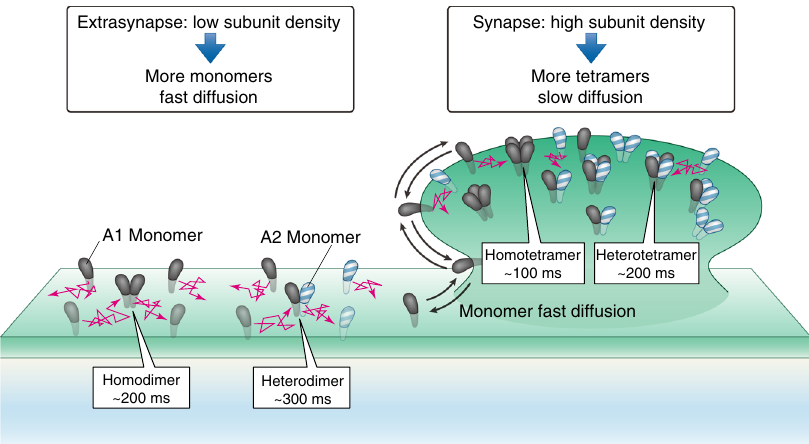
Fig. 9 AMPAR subunits diffuse as monomers and dimers between the dendritic shaft and the synaptic region. Schematic fi gure showing that the AMPAR subunits GluA1 and GluA2 predominantly exist as monomers, and occasionally form transient dimers (and less frequently transient trimers and tetramers) in their reserve pools in the dendritic-shaft PM, where the subunit concentrations are low. Monomers and dimers diffuse quite freely in the dendritic-shaft PM, and enter the spines. In the synaptic regions in the spines, where the AMPAR subunit concentrations are high due to their binding to (plus their transient associations with) scaffolding protein complexes, including PSD95, GRIP, and SAP97 54 , by way of TARP2, tetramers would be the predominant species, which work as L -glutamate-evoked channels. However, the tetramer lifetimes are quite short (a lifetime of 208 ms for the heterotetramers of GluA1 and GluA2, which could be prolonged due to their binding to scaffolding protein complexes). Namely, even in the synaptic regions, tetramers become dissociated readily, whereas monomers turn into tetramers extremely quickly. In this manner, AMPARs with different compositions could be formed readily. Meanwhile, the AMPAR subunit monomers can exit from the synaptic regions quickly, further enhancing the AMPAR composition changes when they are required. This would be useful after LTP induction. As such, the associations and dissociations of AMPAR subunits would play critical